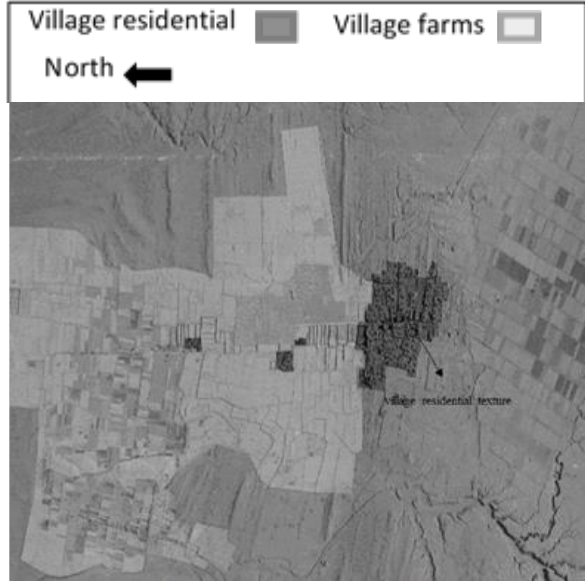
Figure 1. Village aerial photography, Compactness of residential living texture, Year of 1967.